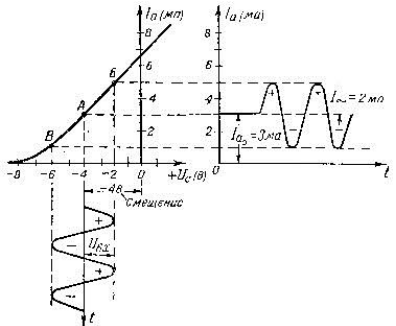
Fig. 5. The process of amplification of a vacuum three- electrode tube of the "audion" type when applying a negative bias to the